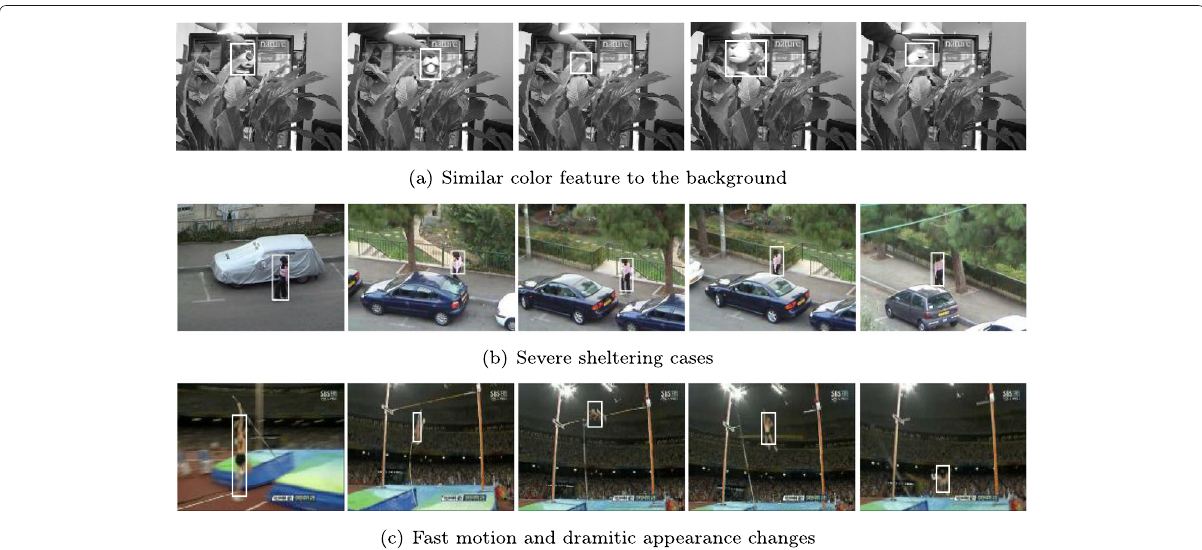
Fig. 5 Further evaluation. a Similar color feature to the background. b Severe sheltering cases. c Fast motion and dramitic appearance